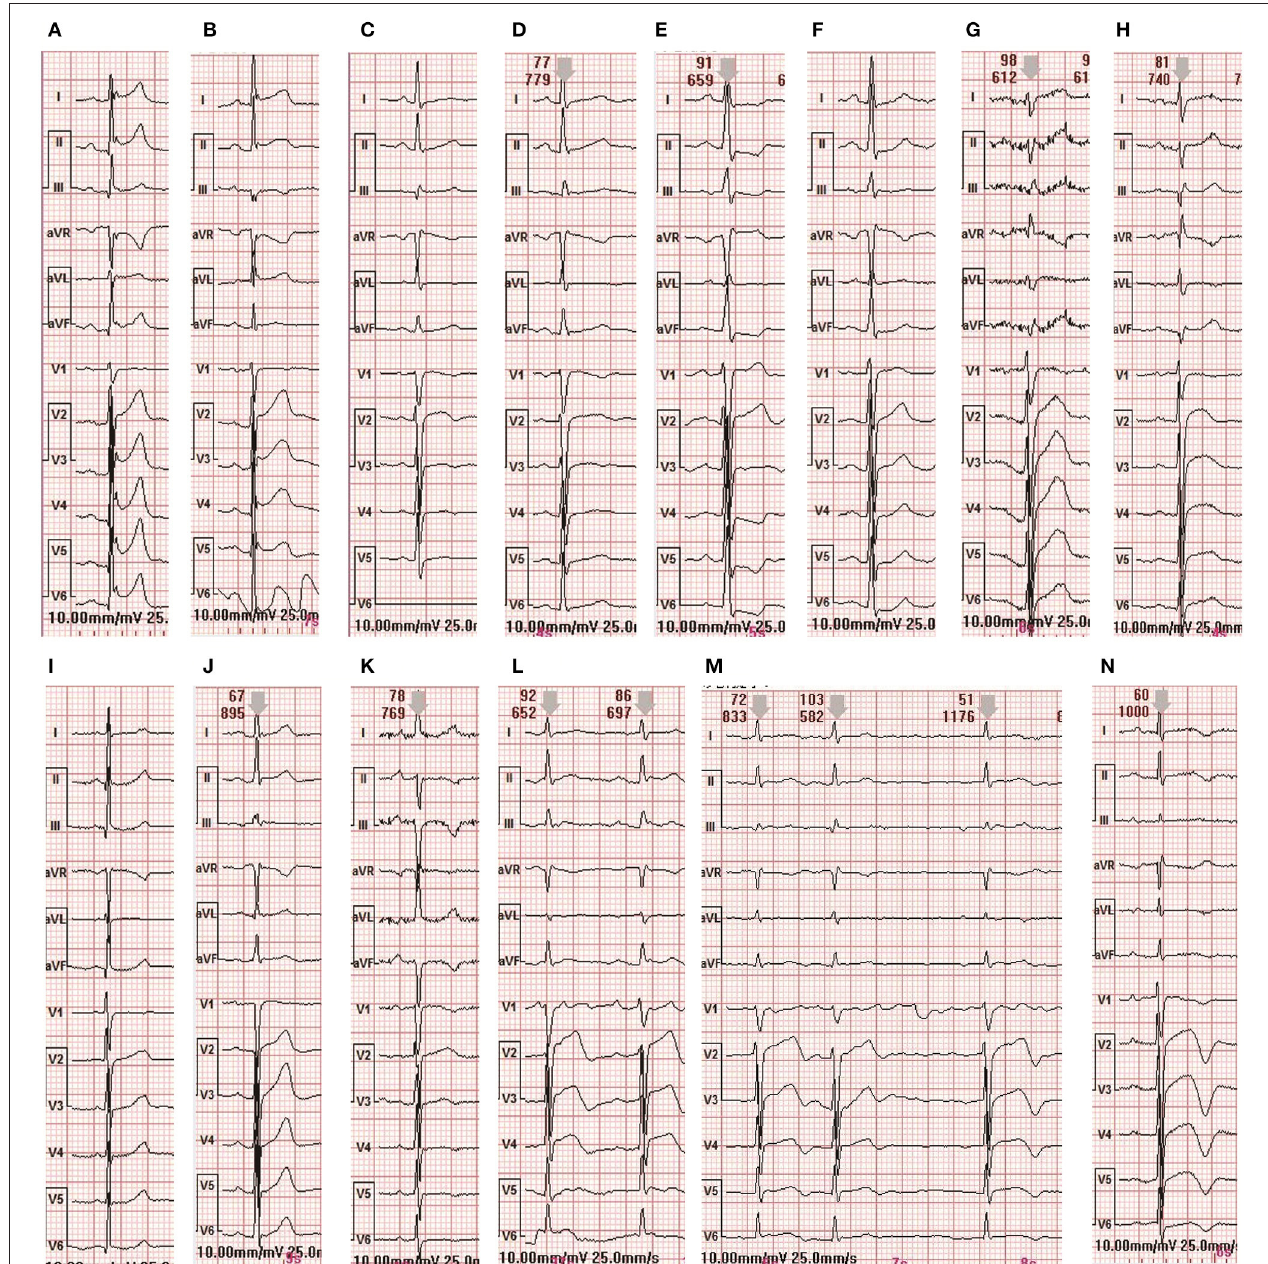
FIGURE 5 | ECG changes in 8 patients during hospitalization (A,B) are the ECG of admission and discharge of case 1 (C,D) are the ECG of admission and discharge of case 2 (E,F) are the ECG of admission and discharge of case 3 (G,H) are the ECG of admission and discharge of case 4 (I) is the ECG of admission and discharge of case 5 (J) is the ECG of admission and discharge of case 6 (K,L) are the ECG of admission and discharge of case 8 (M–O) are the ECG of admission and discharge of case 9.